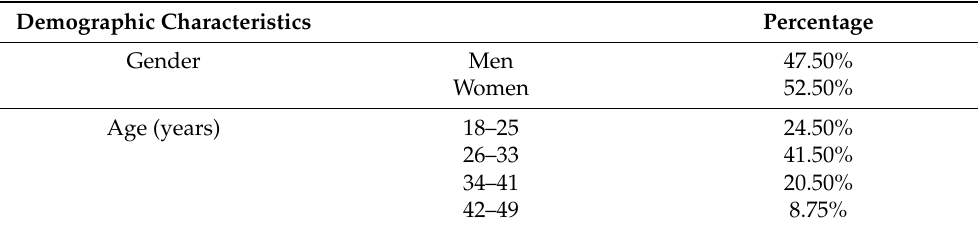
Table 2. Respondents’